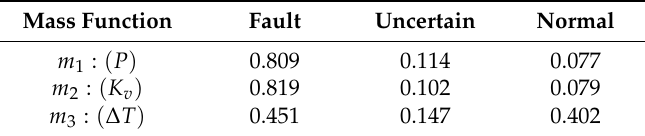
Table 6. The weighted mass functions.